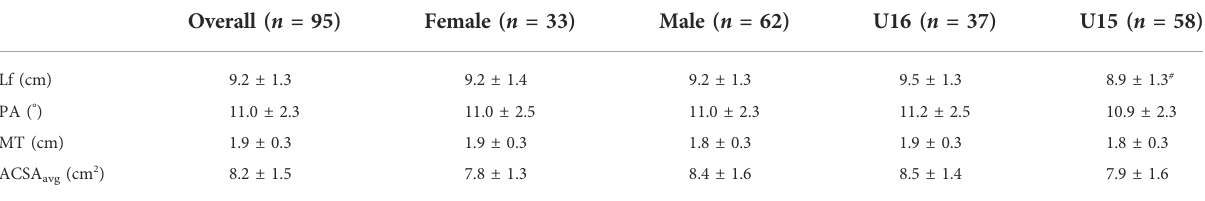
TABLE 2 Overview of the biceps femoris long head morphology at baseline.